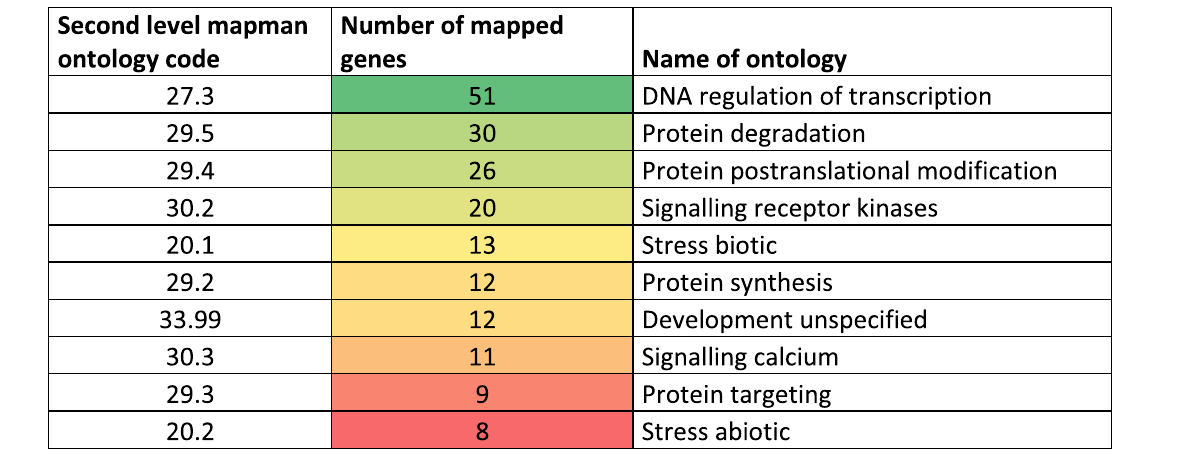
Table 2 Repartition of MapMan mapping of the ten over-represented gene